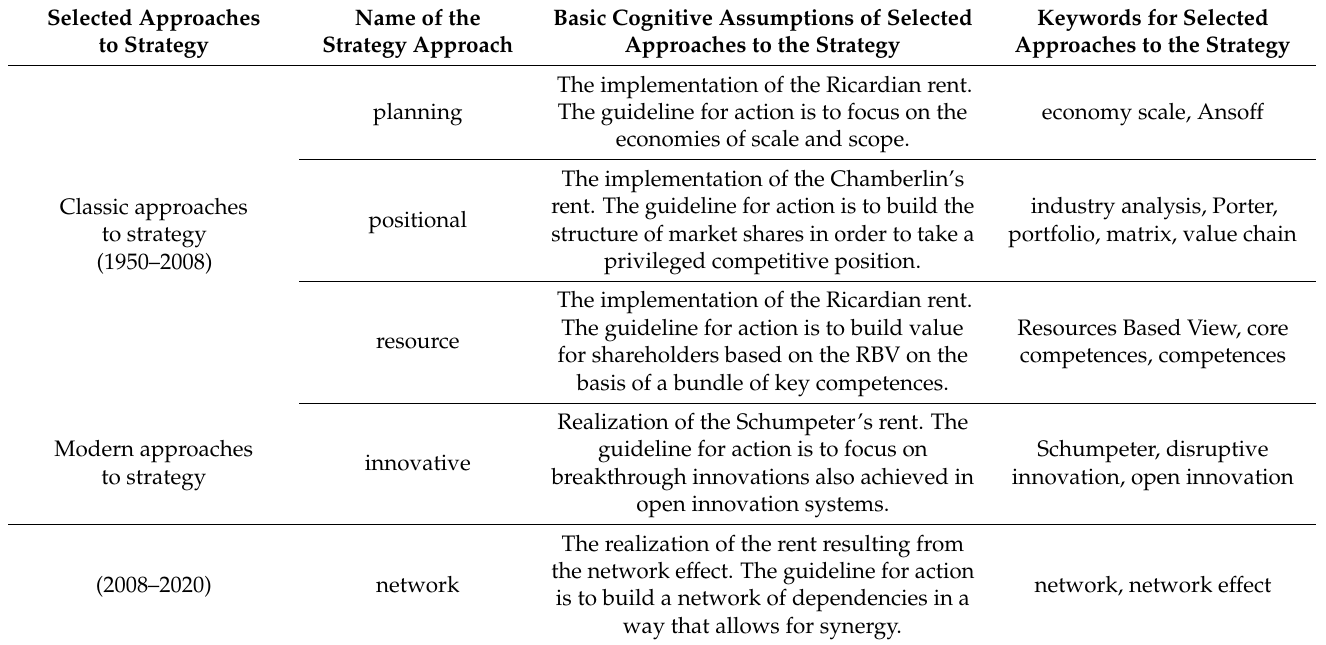
Table 3. Cognitive premises of approaches to strategy selected for the